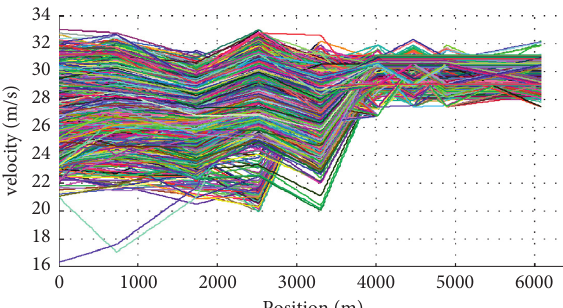
Figure 2: The data of different human driver operations.